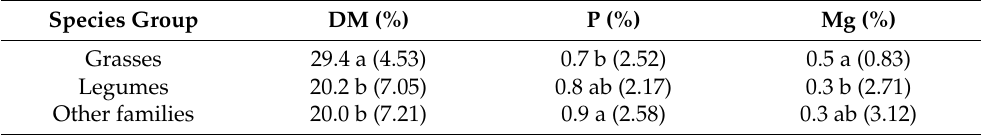
Table 6. Mean values of dry matter (DM) and nutrient concentrations with significant differences in grasses, legumes and other families. Species Group DM